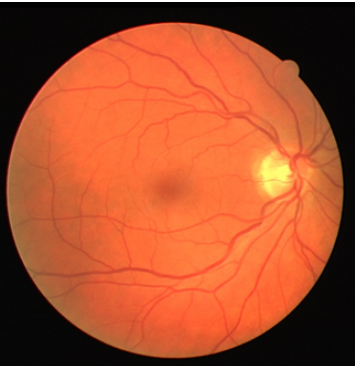
Figure 1. Example of a fundus image from DRIVE dataset.